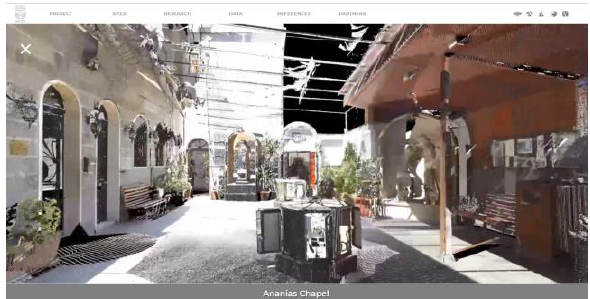
Figure 6. Ananias Chapel – Point Cloud Animation